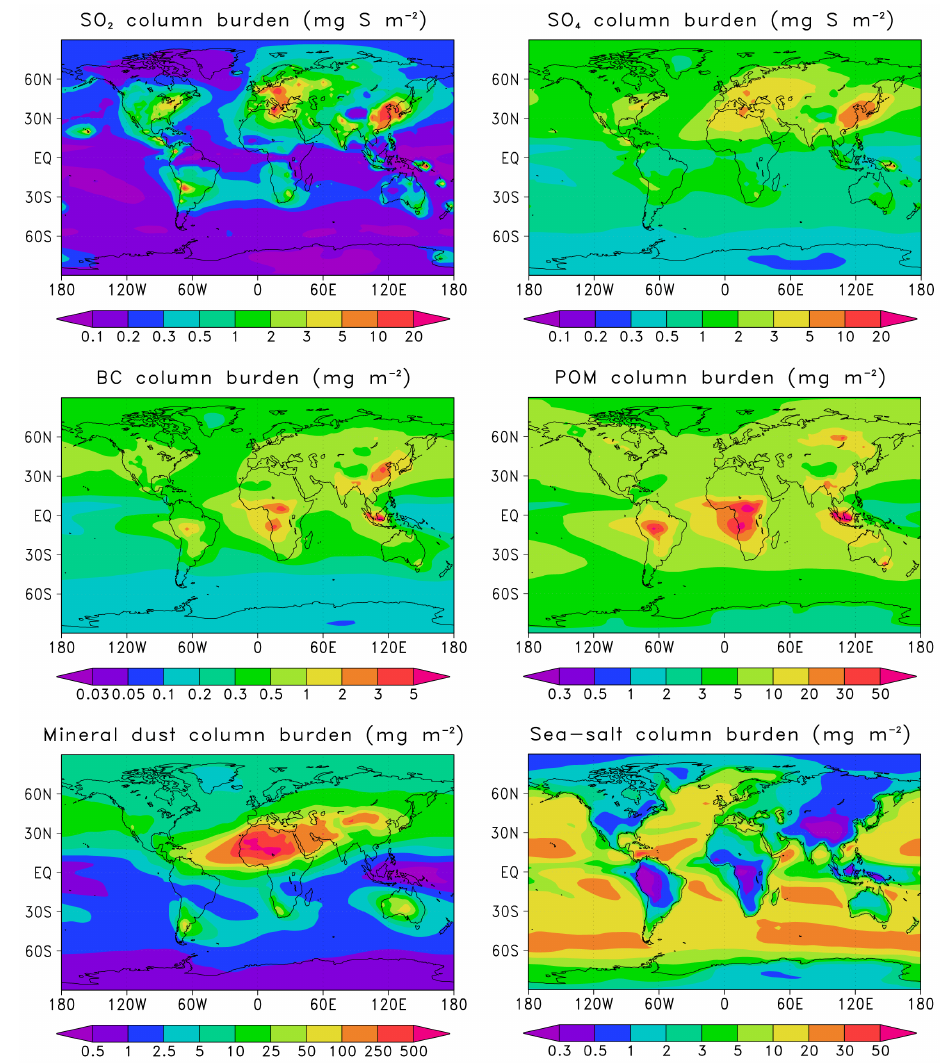
Fig. 2. Annually averaged vertically integrated mass columns of SO 2 and aerosol constituents in the Ctrl simulation. Globally averaged columns are 0.554mgSm − 2 for SO 2 , 1.34mgSm − 2 for sulphate, 0.466mgm − 2 for BC, 7.49mgm − 2 for POM, 23.0mgm − 2 for mineral dust, and 9.62mgm − 2 for sea